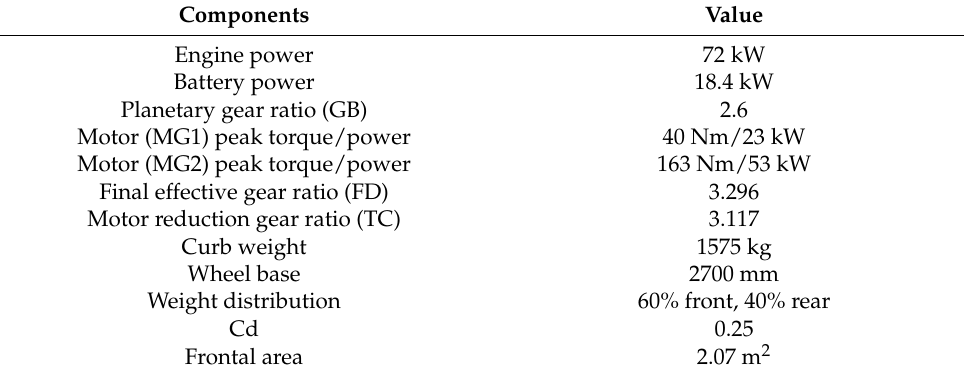
Figure 2. Component-sizing optimization process with vehicle simulation. The POUNDERS algo- rithm updates the parameter configuration to minimize the cost function value and vehicle simu- lation, with PMP runs targeting the driving cycles with updated parameter configurations from POUNDERS. 3.1. Pontryagin’s Minimum Principle PMP is an optimal control strategy that can be applied to systems that are nonlinear and non-differentiable, such as hybrid electric vehicle powertrains. PMP does not require much calculation time because it provides a simple solution while ensuring optimality when certain conditions are satisfied. It is derived from the Euler – Lagrange equation in